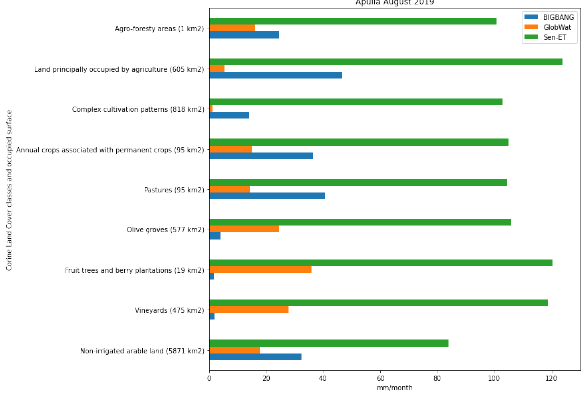
Figure 12. Comparison of ET values generated by BIGBANG, GlobWat and Sen-ET models for the Apulia area in August